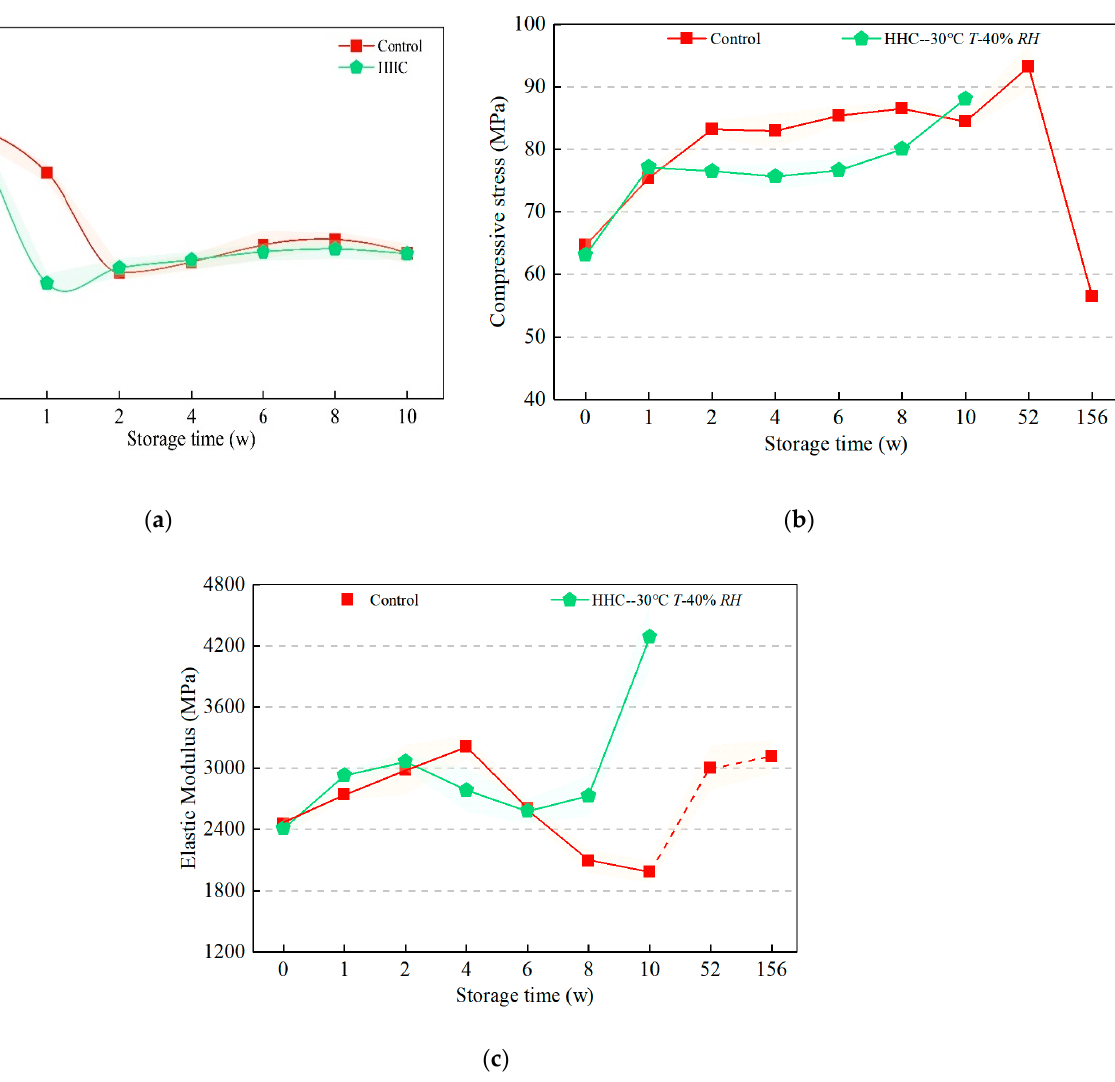
Figure 10. Effect of humidity heat cyclic ageing on moisture content and axial compression properties of bamboo. ( a ) Moisture content of the treated and control group samples during storage. ( b ) Compressive stress of treated and control group samples during storage. ( c ) Elastic modulus of treated and control group samples during storage.